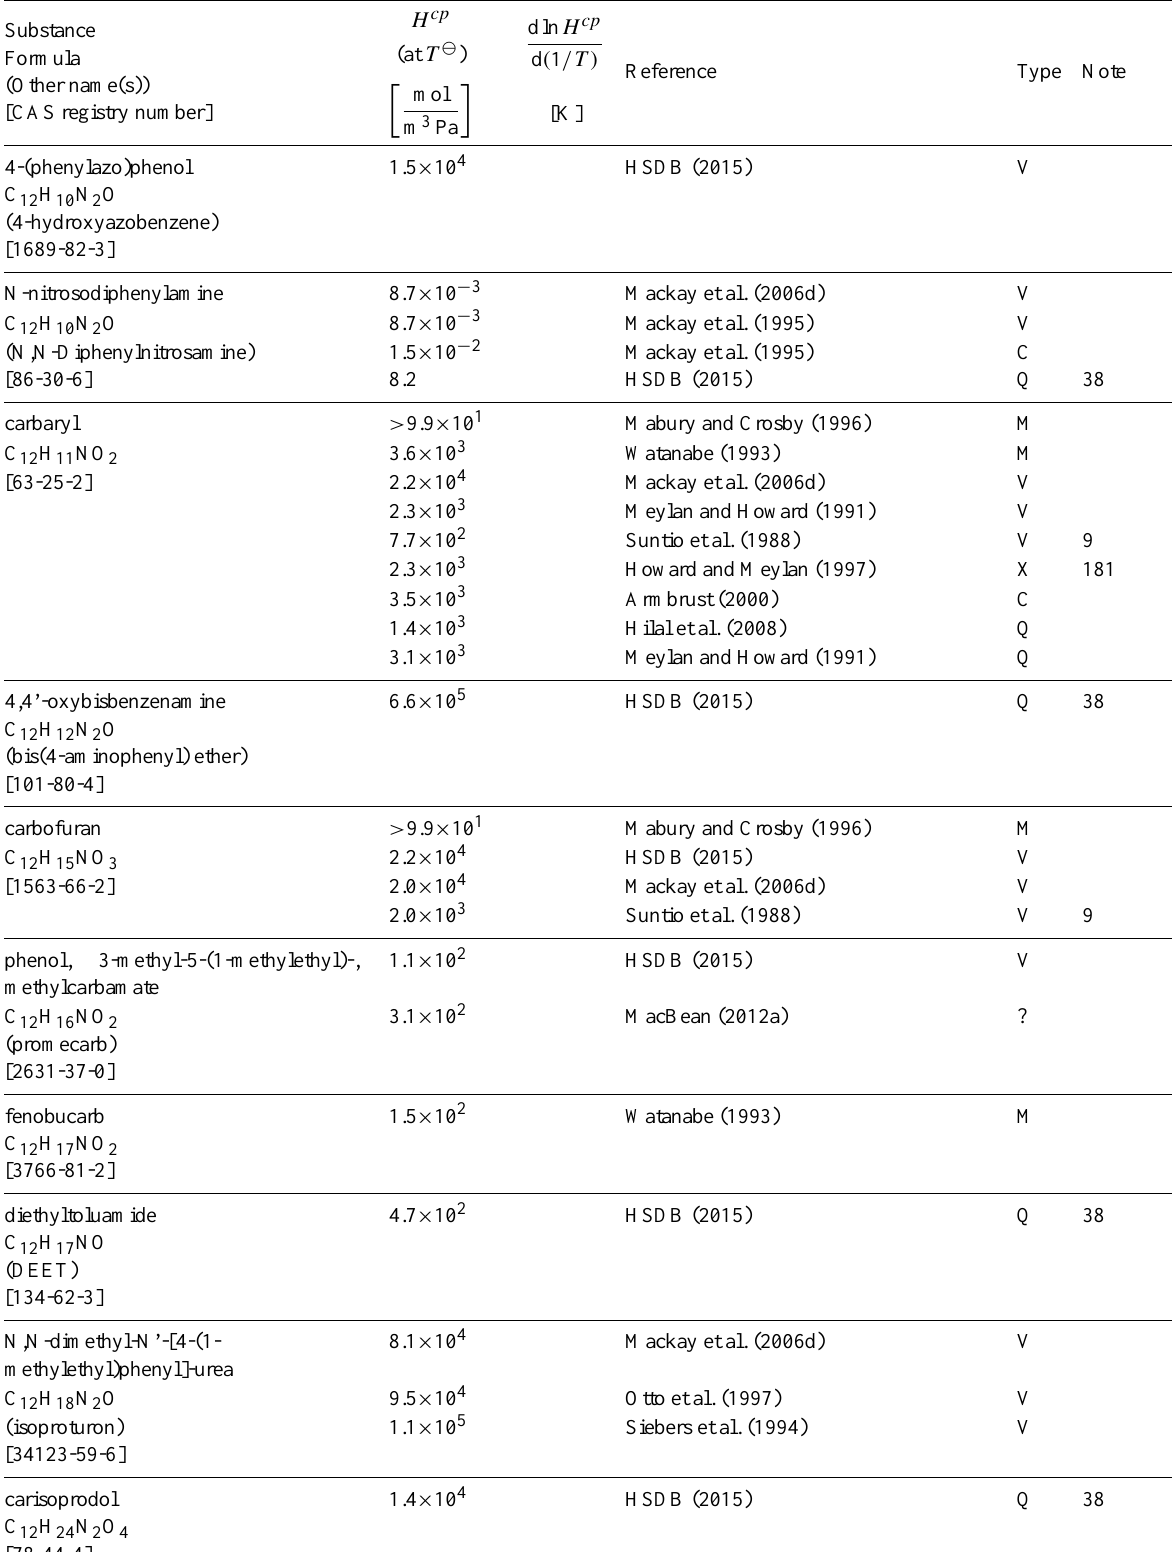
Table 6: Henry’s law constants for water as solvent